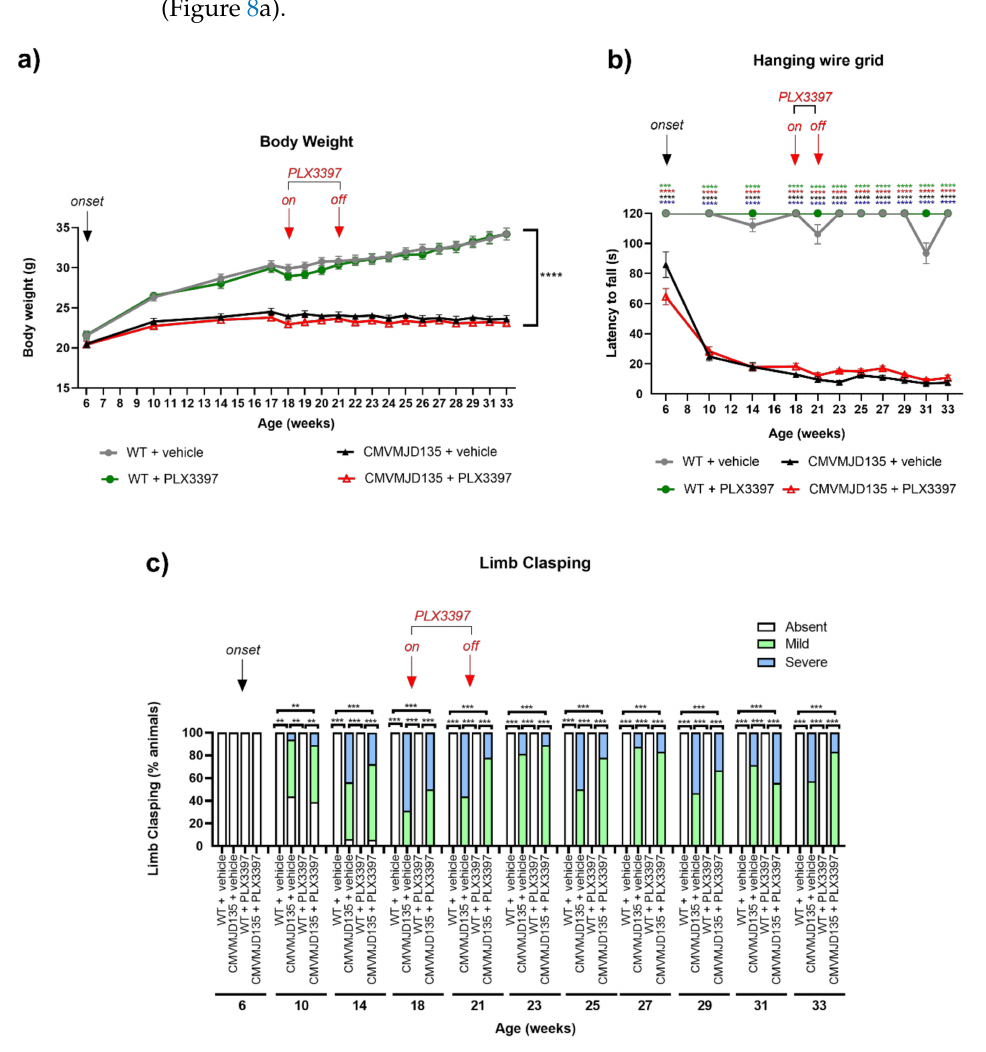
Figure 8. PLX3397-treatment did not modify the loss of muscular strength and abnormal reflexes seen in CMVMJD135 mice. ( a ) Assessment of body weight showed significant differences between CMVMJD135 mice (PLX3397- and vehicle-treated) and WT mice (PLX3397- and vehicle-treated) throughout time. One-way ANOVA (post hoc Tukey’s test). ( b ) In the hanging wire grid test, in all the analyzed timepoints, CMVMJD135 mice (PLX3397- and vehicle-treated) showed a significantly lower latency to fall from the grid when compared to WT mice (PLX3397- and vehicle-treated). Asterisks indicate significant differences which were found between: * WT + vehicle and CMVMJD135 + vehicle; * WT + vehicle and CMVMJD135 + PLX3397; * WT + PLX3397 and CMVMJD135 + vehicle; and * WT + PLX3397 and CMVMJD135 + PLX3397. Friedman test with Kruskal–Wallis analysis. ( c ) Abnormal reflexes observed in the transgenic mice were not significantly improved by the PLX3397 treatment. Friedman test with Kruskal–Wallis analysis. Values are presented as mean ± SEM or as percentage of animals (%) (for the continuous and non-continuous variables, respectively). Means were considered statistically significant at a p -value. ** p < 0.01, *** p < 0.001, **** p <